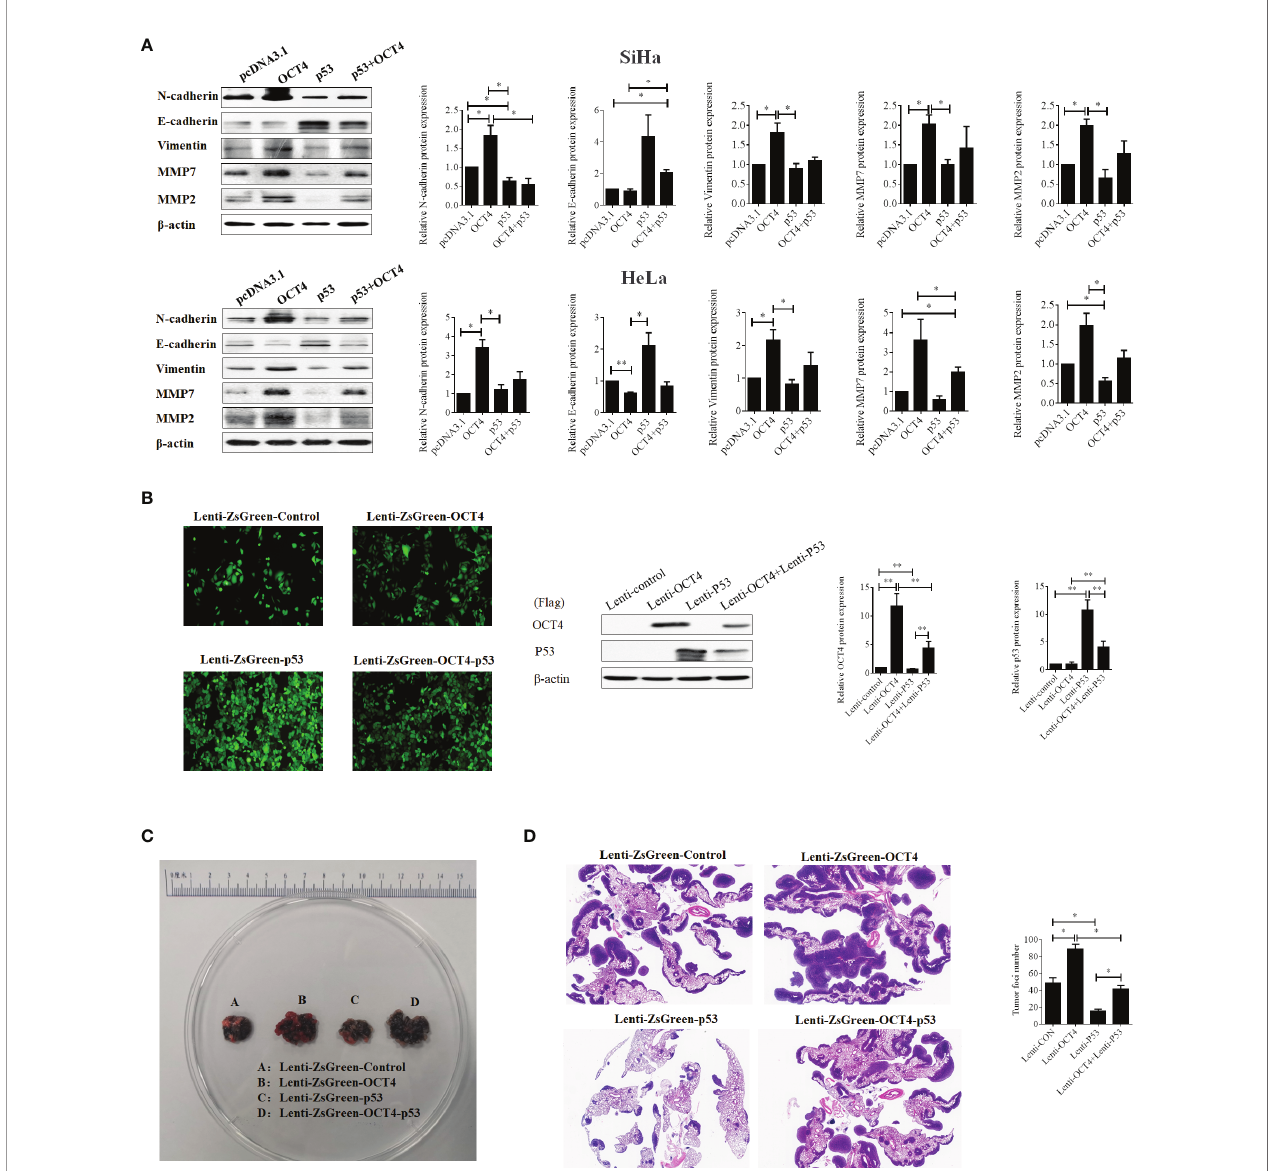
FIGURE 9 | The ectopic expression of OCT4 regained the metastasis of cervical cancer inhibited by p53 via promoting the EMT and the expression of MMP7 and MMP2. (A) The SiHa and HeLa cells were transfected with pcDNA3.1-OCT4 and pcDNA3.1-p53 alone or in combination, and the protein was extracted after 24 h of transfection. Then, the protein levels of N-cadherin, E-cadherin, vimentin, MMP7, and MMP2 were detected by Western blot. (B) Representative photographs for HeLa cells with stable overexpression of OCT4 and/or p53 examined by a fl uorescence microscope (left panel), while the WB assay was used to determine the expression of OCT4 and p53 proteins (right panel). (C) Lung images of nude mice injected with HeLa cells with stable overexpression of OCT4 and/or p53 via the tail vein. (D) HE staining of lung images of nude mice injected with HeLa cells with stable overexpression of OCT4 and/or p53 via the tail vein. * p < 0.05, ** p < 0.01 vs.